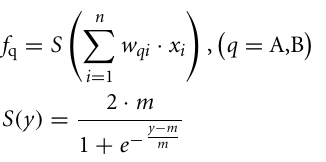
FIGURE 2 | Opponent processing model for temporal order judgments. (A) The tuning curves of several hypothetical “delay sensitive” neurons which have the strongest responses for specific delays between motor and sensory events. (B) Diagram of the pooling opponent processing circuits. Orange circles represent the hypothetic lower level delay sensitive neurons with different preferred delays between motor action and sensory input. Blue